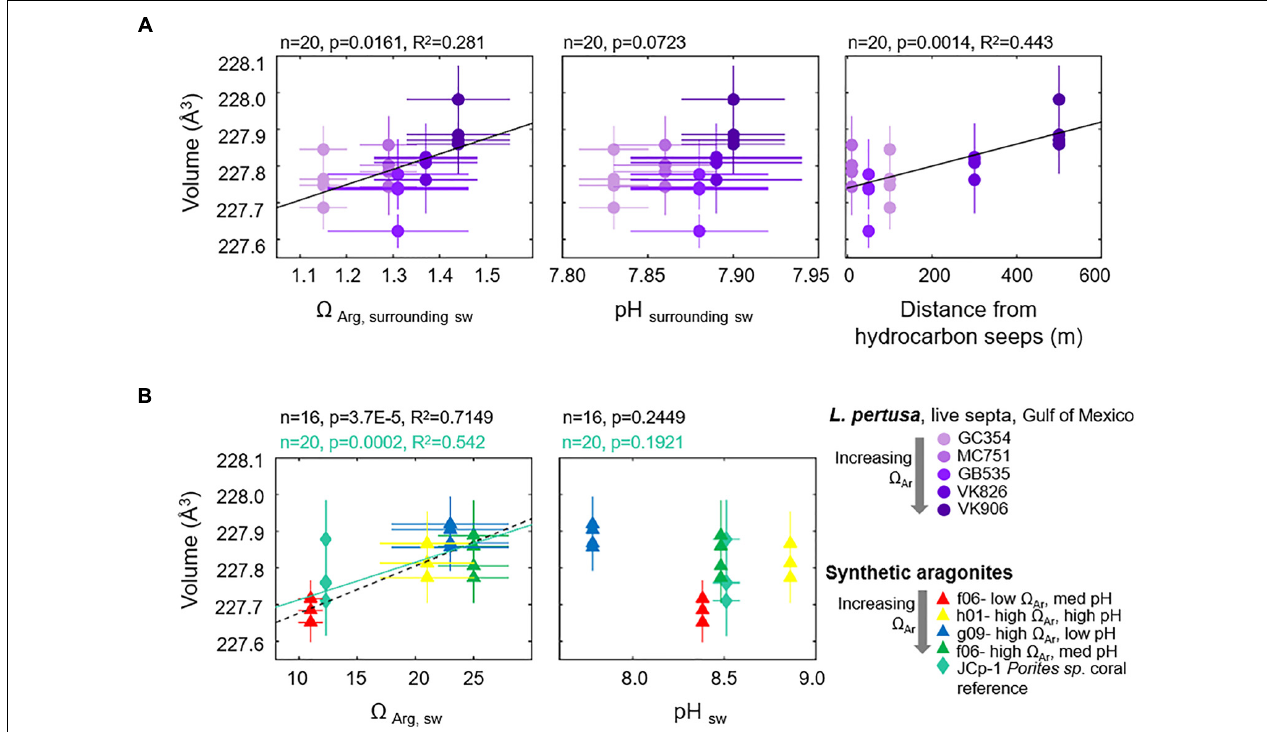
FIGURE 4 | Unit cell volumes of aragonite as a function of environmental variables for (A) Gulf of Mexico L. pertusa live septa samples (violet circles) versus surrounding seawater chemistry at colony collection sites, and (B) synthetic aragonites precipitated from seawater versus seawater formation chemistry (triangles, black dashed trend line). A JCp-1 reference coral with known internal calcifying fluid chemistry is also added (mint-green diamonds, solid trend line) as a comparison to synthetic